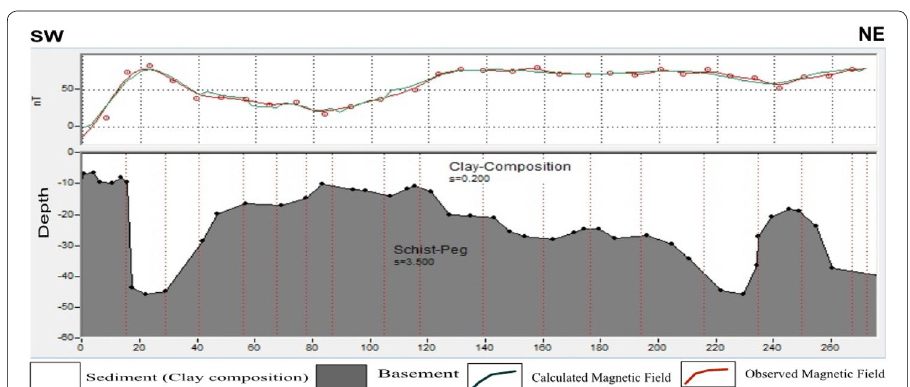
Fig. 16 Model of magnetic profile along traverse